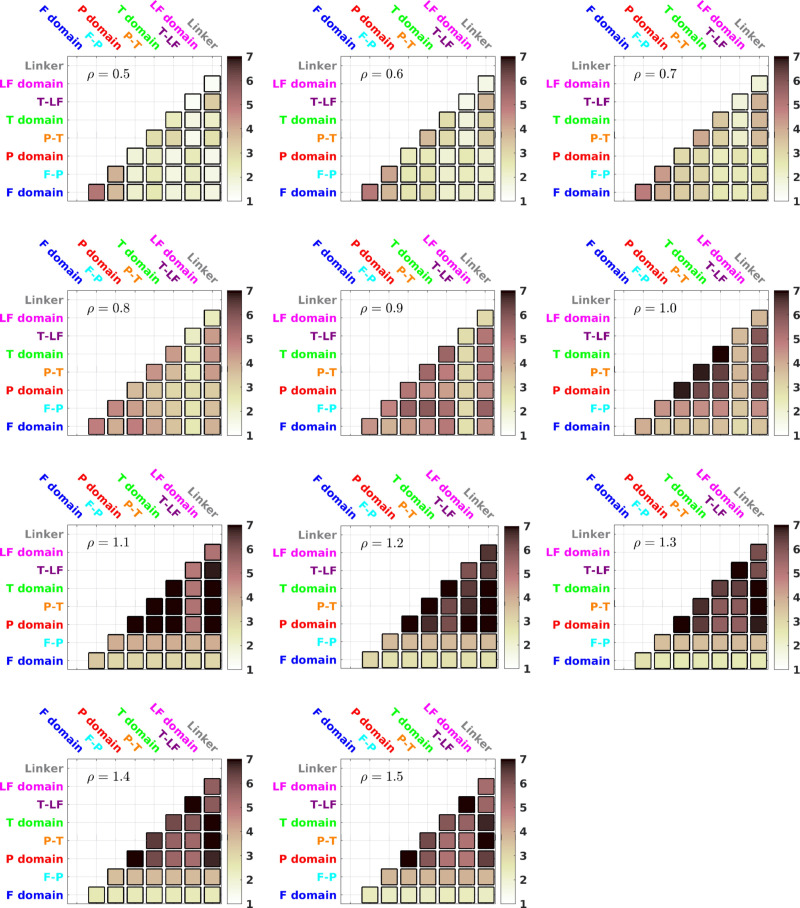
TCI for different values of ρ.TCII,J between different domains/interfaces (I,J) for different values of ρ.